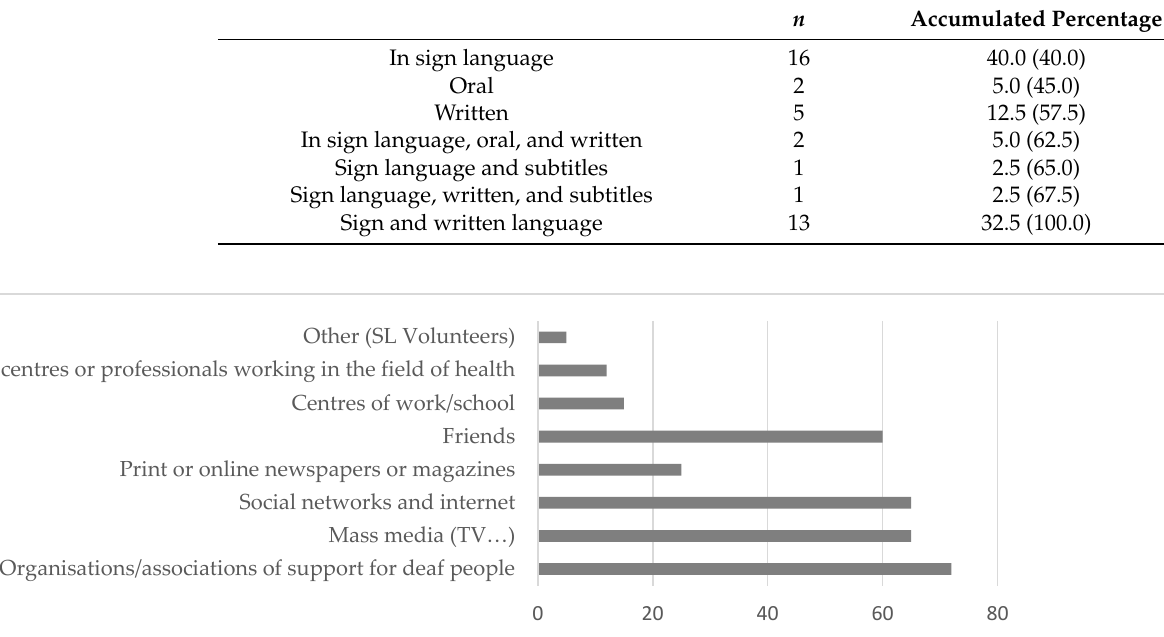
Figure 8. Percentage of use of information sources.